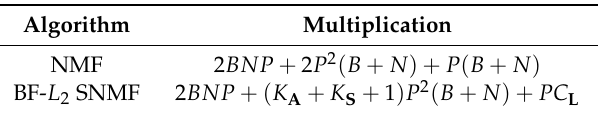
Table 1. Multiplication operation times in each iteration for nonnegative matrix factorization (NMF) and bilateral filter regularized L 2 sparse NMF (BF- L 2